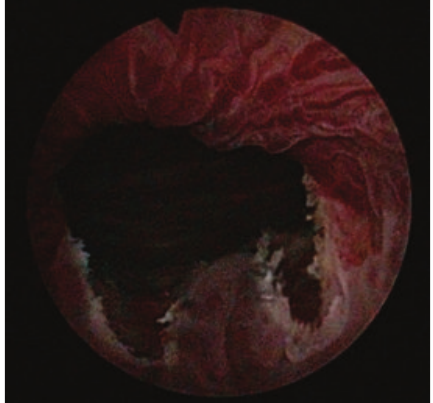
Figure 2: Transurethral incision of the bladder neck in a woman with a primary bladder neck obstruction. Final view of the transurethral incision of the bladder neck at the 5- and 7-o’clock position.